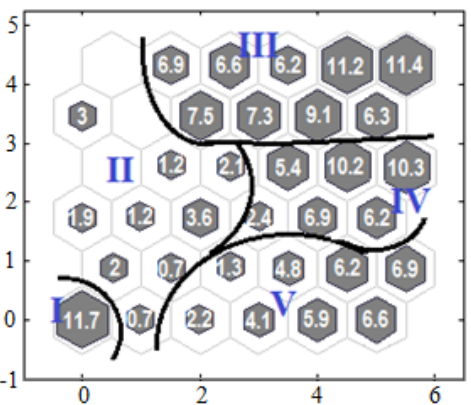
Figure 7. The average hit histogram of 10 results of SOM obtained from the RQA of a pressure drop time series.